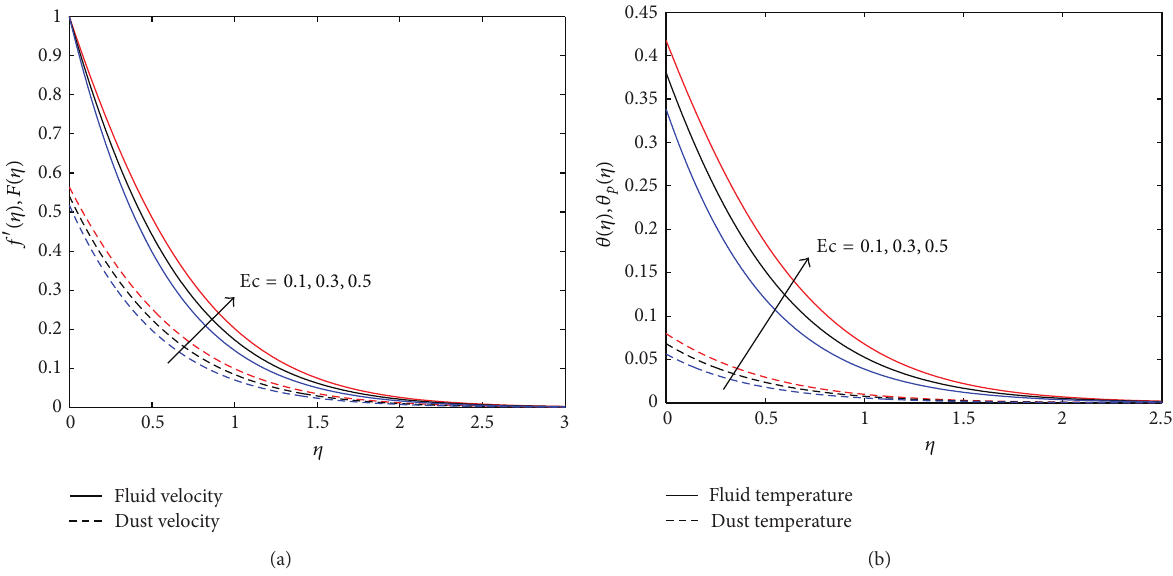
Figure 6: Effect of Ec on (a) 𝑓 󸀠 , 𝐹 and (b) 𝜃 , 𝜃 𝑝 when 𝑀 = 1 , 𝑆 = 2 , 𝑁 = 1 , 𝛽 ℎ = 1 , and Bi = 1 .